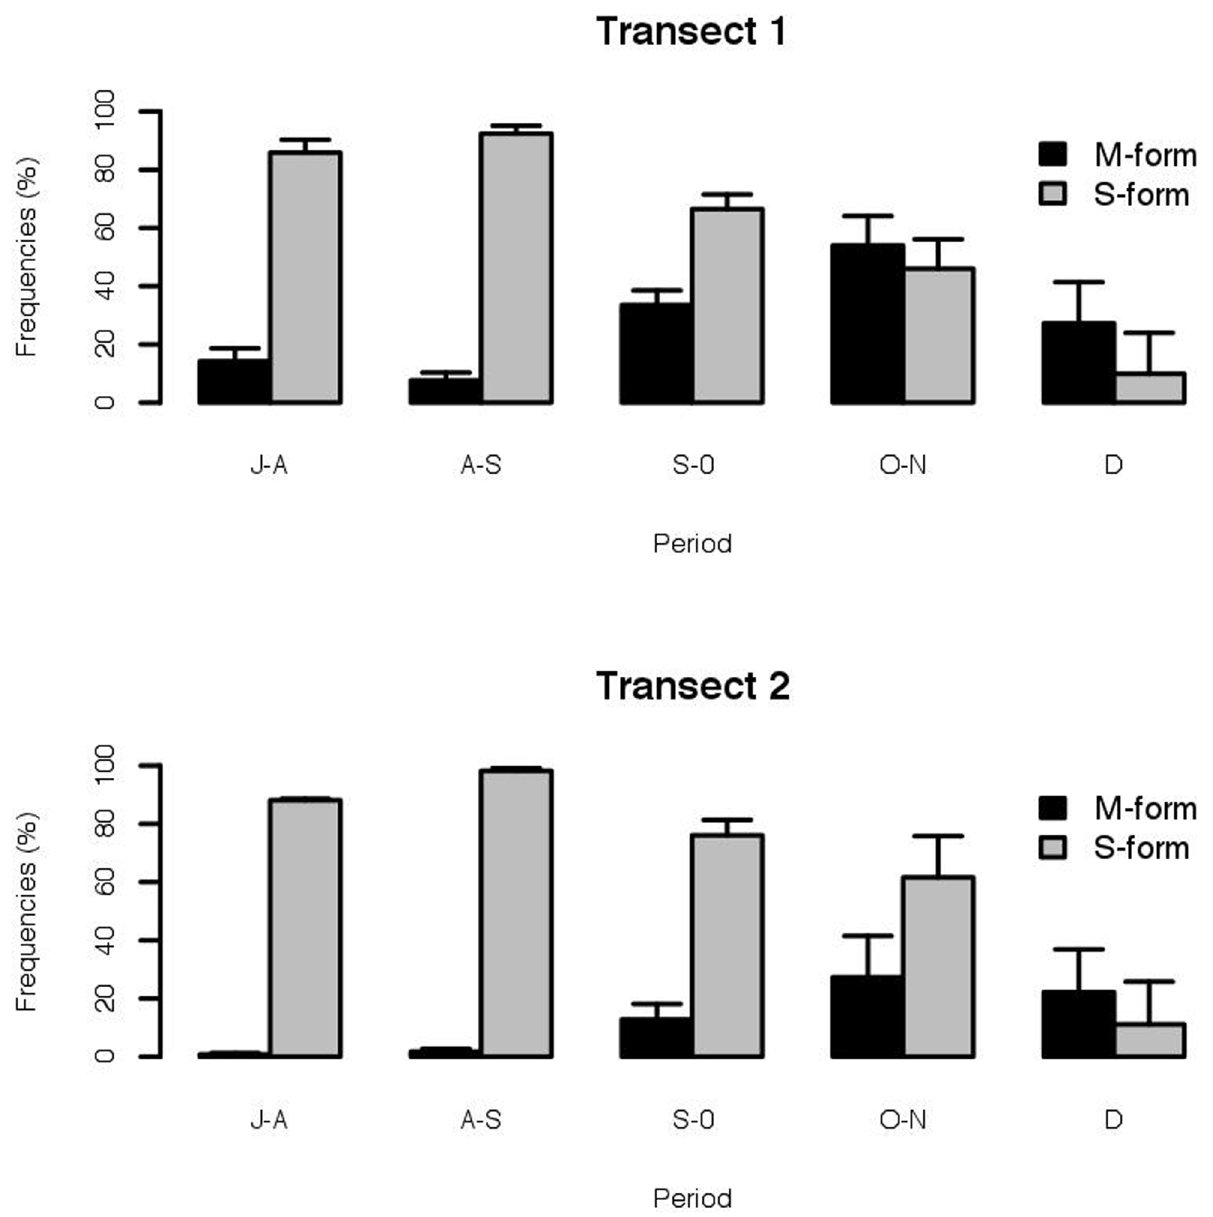
Figure 3. Temporal variations of the mean frequencies of M and S forms in each of the two transects from July to December 2010. Bars represent standard errors. For each period, collections took place from the last week of a given month to the first week of the following month.